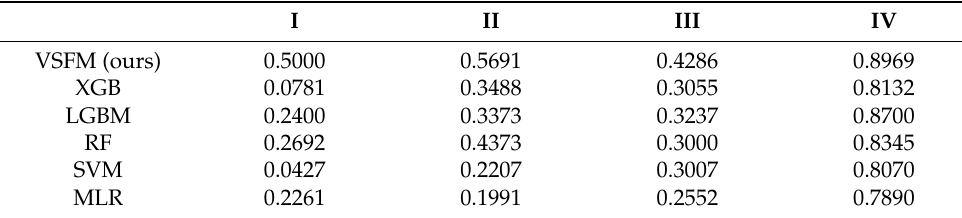
Table 6. TS score performance in all seasons for different